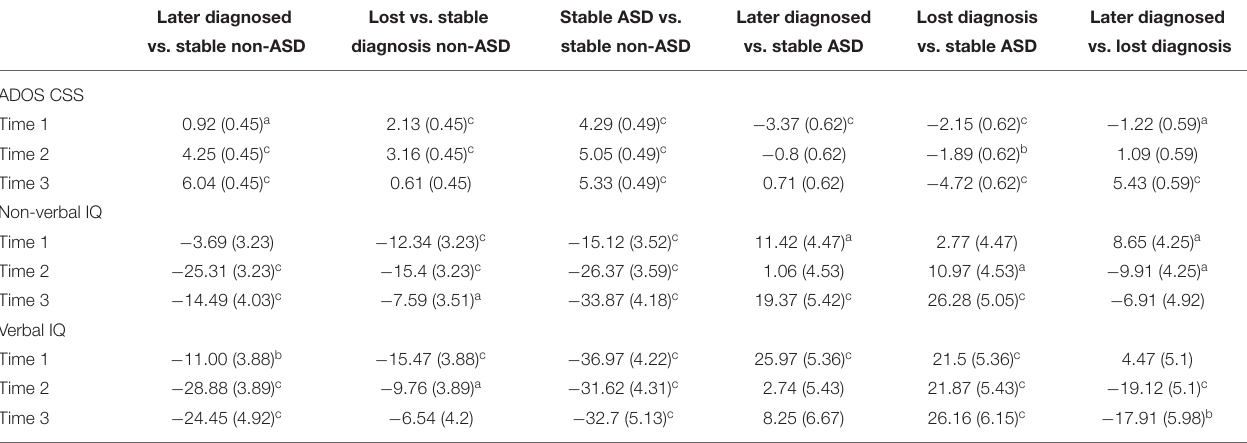
TABLE 5 | Estimated pairwise group differences (SE) in autism symptom severity, non-verbal intelligence, and verbal intelligence across all time points. Later diagnosed Lost vs. stable Stable ASD vs. Later diagnosed Lost diagnosis Later diagnosed vs. stable non-ASD diagnosis non-ASD stable non-ASD vs. stable ASD vs. stable ASD vs. lost diagnosis ADOS CSS